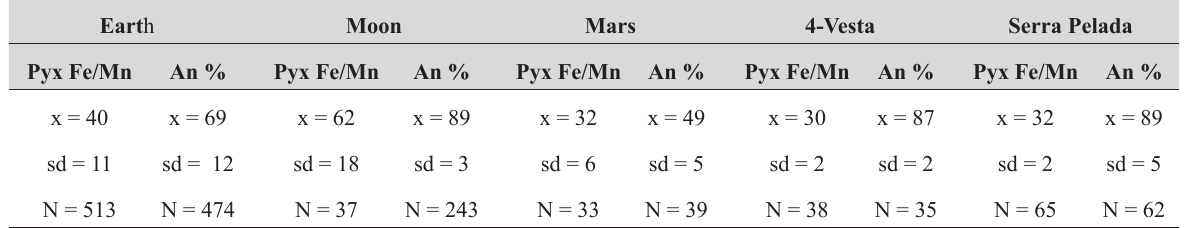
Comparing Serra Pelada pyroxene and plagioclase data with others planetary basalts. These literature data were taken from Papike et al. (2003). Pyx: pyxroxene; An: Anothite-bytownite.